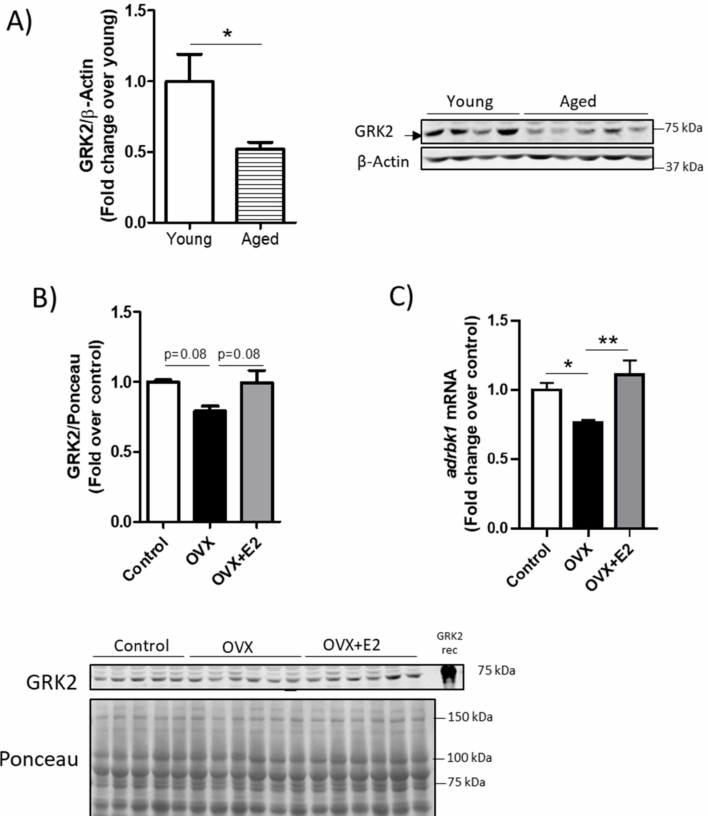
Figure 4. Modulation of GRK2 protein levels in females upon aging or ovariectomy in skeletal muscles is opposite to that of the cardiac muscle. Young and aged female mice were euthanized, and the soleus and gastrocnemius were surgically removed and processed for Western Blot and probed with antibodies against GRK2 and β -actin. ( A ). Effects of ovariectomy and estradiol (E2) replacement in the gastrocnemius muscle of rats probed with antibodies against GRK2 and normalized by the Ponceau staining [38], n = 5–6, ( B ) and in adrbk1 mRNA levels normalized by gapdh as detected by qPCR, n = 5–6 ( C ). Representative immunoblots and densitometric analysis of 4–6 animals per group are shown. Results are represented as means ± SEM, statistical analyses were performed using one-way ANOVA followed by Bonferroni’s post-hoc test ( B , C ) or an unpaired t -test ( A ) * p <